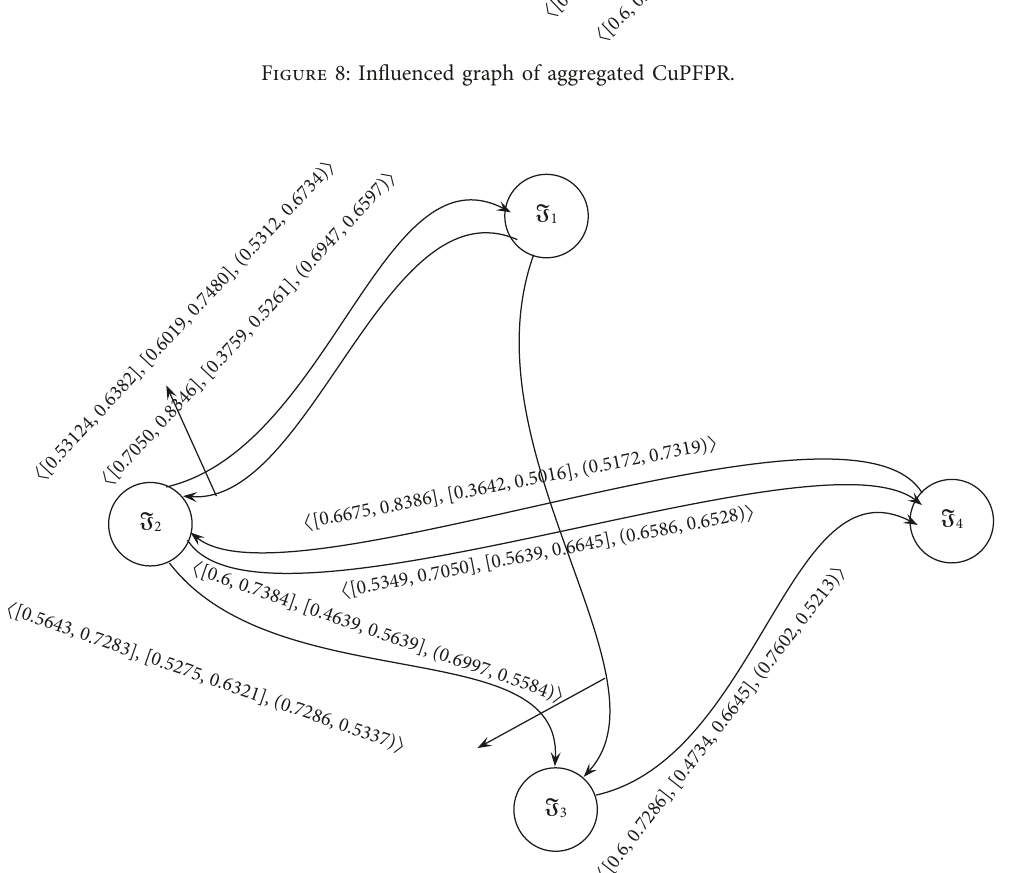
Figure 9: Partial influenced graph of aggregated